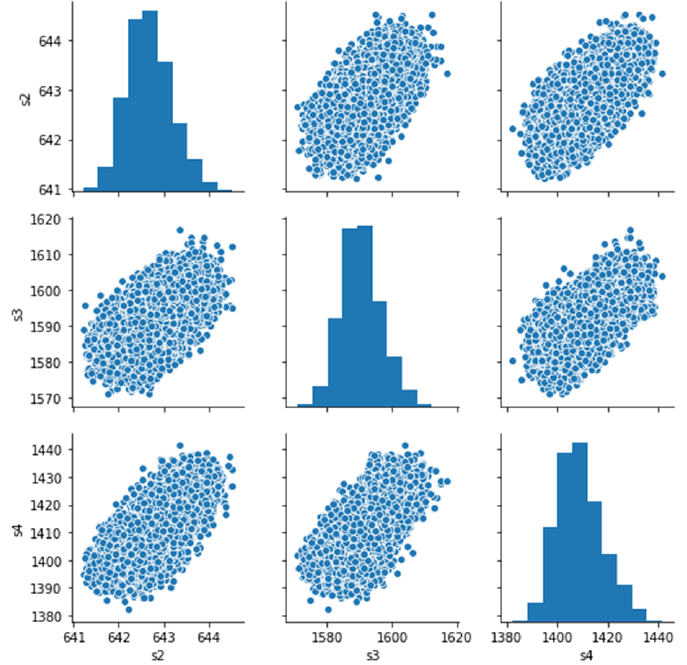
Figure 5. Correlation plot of variables (sensor2, sensor3, and sensor4) of FD001.